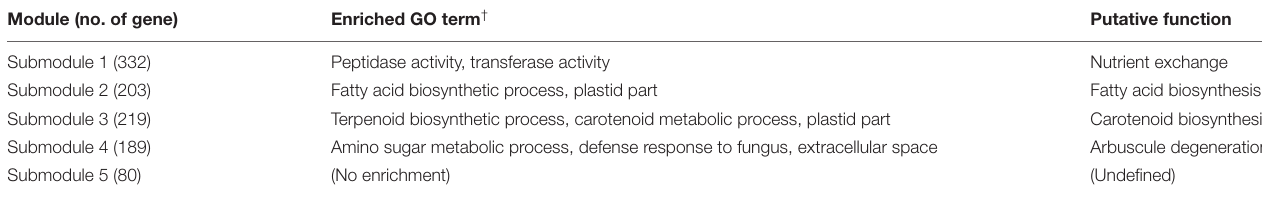
TABLE 2 | Enriched Gene Ontology (GO) terms and putative function of the submodules of the mycorrhizal module. Module (no. of